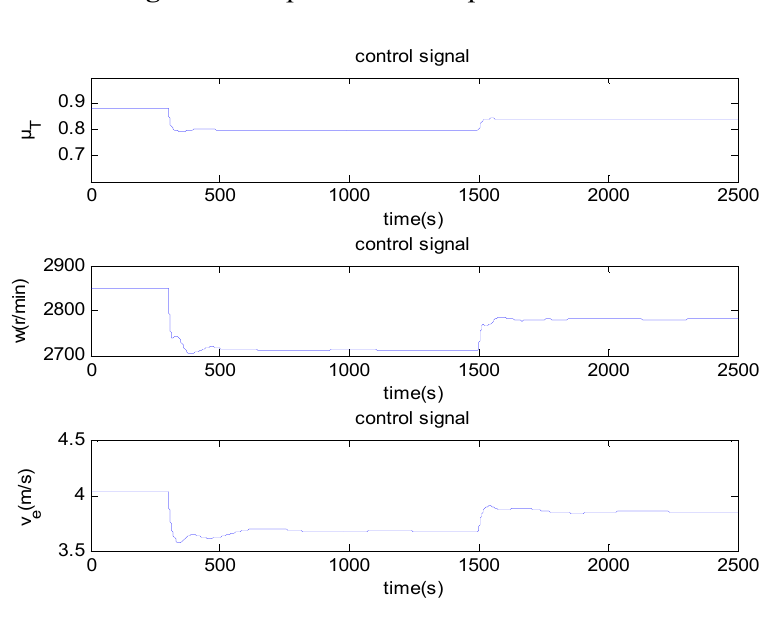
Figure 4. Responses of manipulated